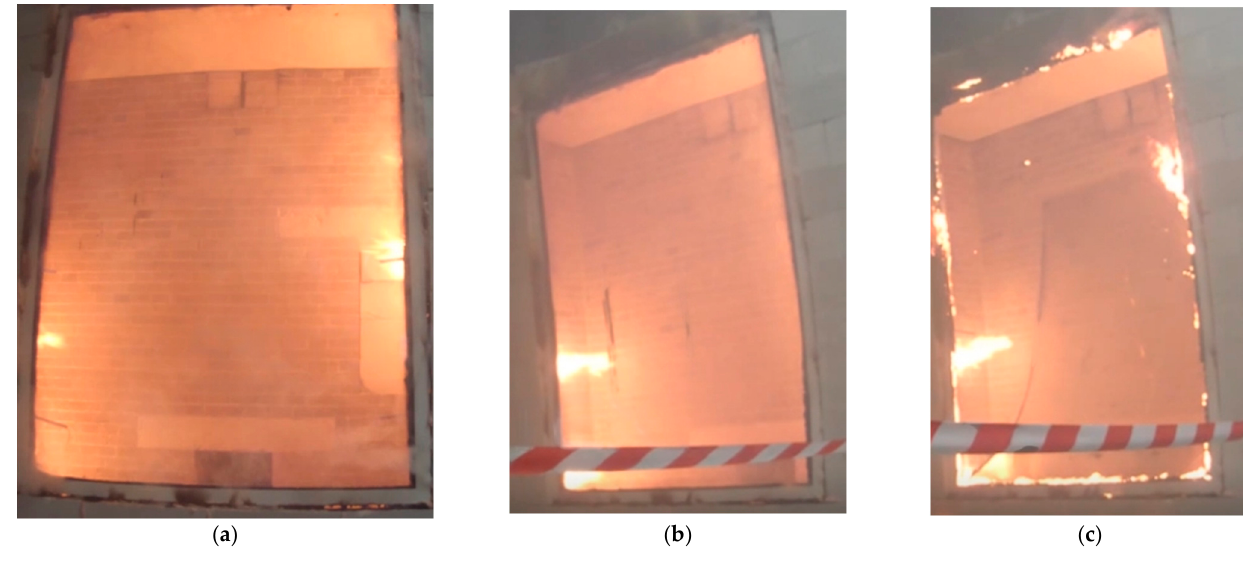
( b ) Figure 6. Large-sized sample No. 2.2 ( a ) during fire exposure and ( b ) at the end of fire exposure. Photo by the authors. In the large-scale test for sample No. 2.3, it was found that the fire resistance limit, tested under standard temperature conditions, was reached at 46 min due to the appear- ance of a steady flame for 10 s on the unheated side of the glass and the glass subsequently falling out of the test steel frame, which corresponds to a fire resistance limit of E45. It was noted that during the experimental studies of samples No. 2.2 and No. 2.3, the steel frame was deformed first, which consequently caused the glass to fall out of the test frame. In the large-scale test for sample No. 2.4, it was found that the fire resistance limit, tested under standard temperature conditions, was reached at 75 min due to the appearance of